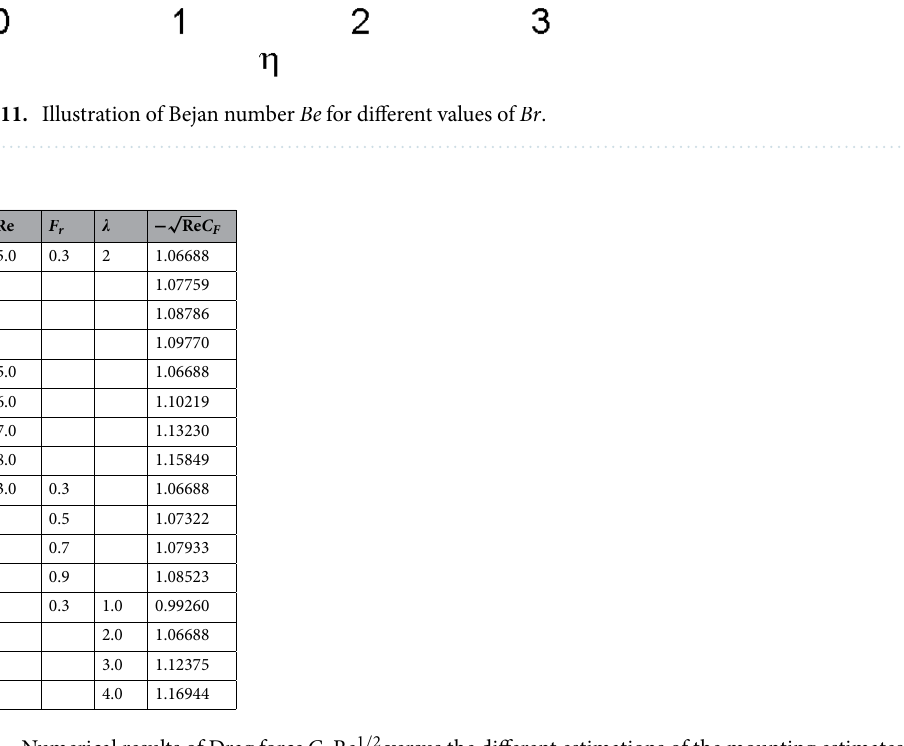
Table 4. Numerical results of Drag force C F Re the M , (cid:31) , Re, F r